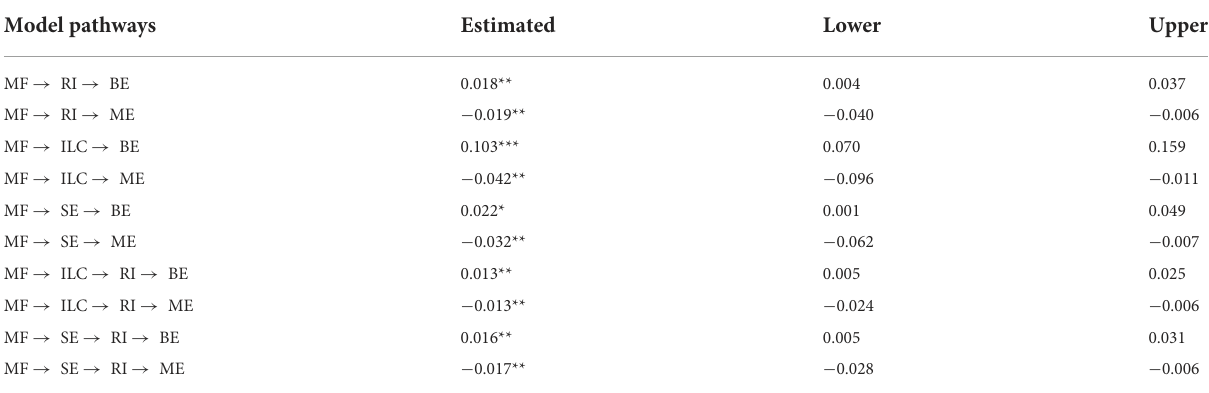
TABLE 3 Standardized indirect effects and 95% CIs. Model